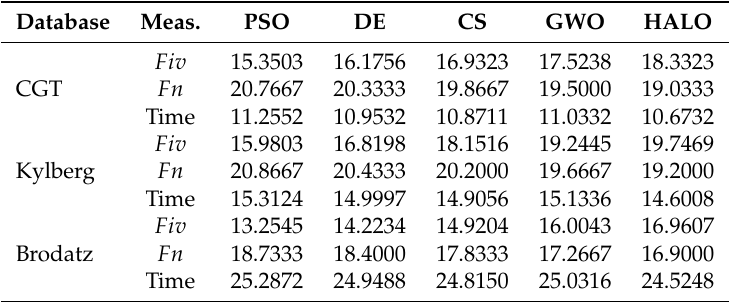
Table 2. Result of different algorithms for public texture